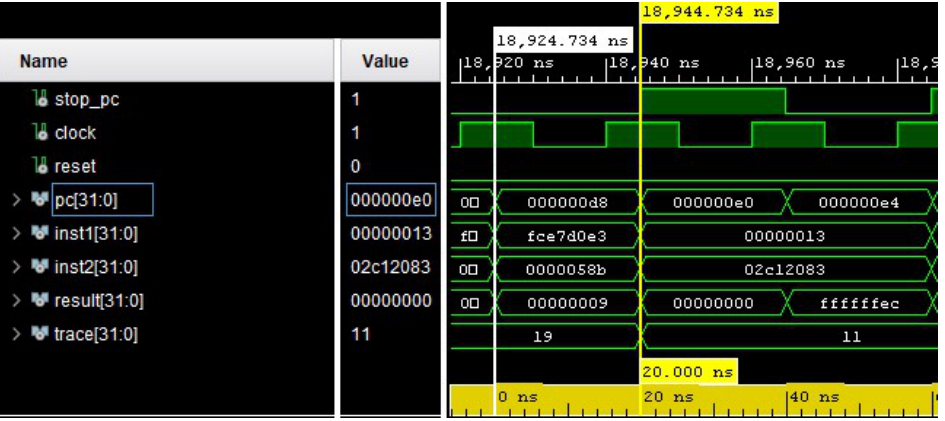
Figure 12. Execution results of a pair composed of a conditional jump (0xd8) and a trace instruction (0xdc). In the first cycle, the jump is not effective, and the trace instruction is executed, changing its value from 19 to 11. The remaining cycles execute the corresponding instructions after the conditional